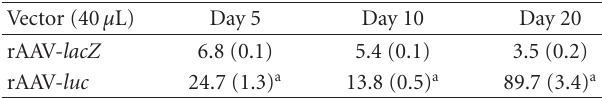
Table 1: Luciferase activity in transduced human chondrosarcoma cells in vitro